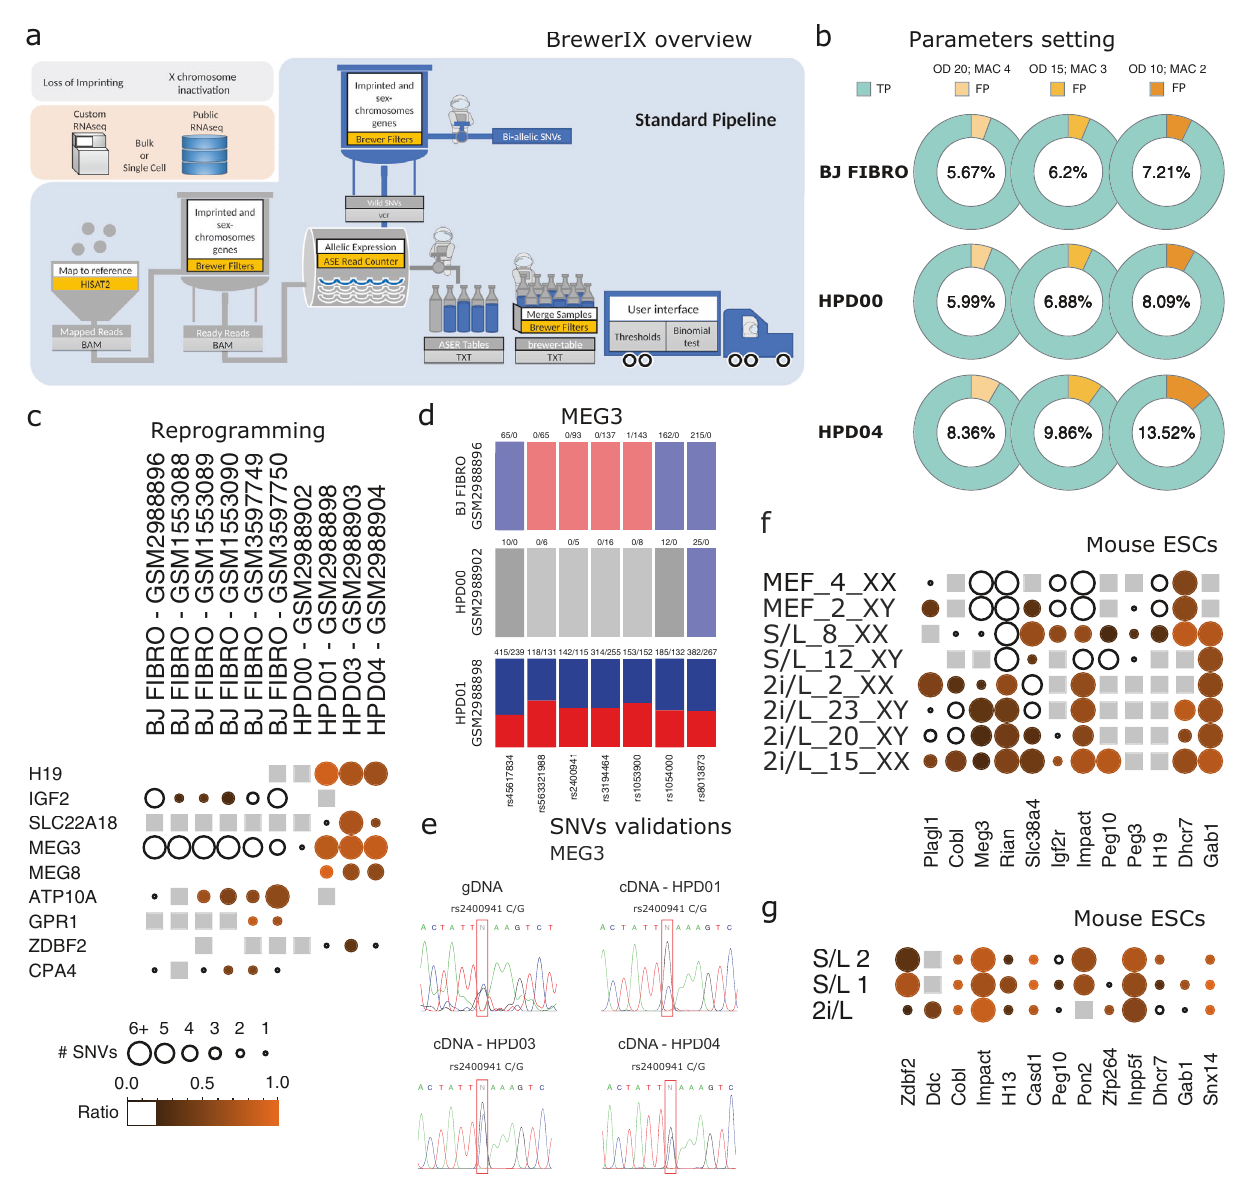
Fig. 1 Analyses of imprinted gene expression in naive pluripotent cells with BrewerIX. a BrewerIX rational and overall implementation scheme for the Standard pipeline. b False discovery rate estimates obtained by comparing WES calls and BrewerIX biallelic calls in one male BJ fi broblast and two iPS cell lines. Three threshold combinations of overall depth (OD) and minimal coverage of the minor allele (MAC) were used; true positives (TP) in cyan; false positives (FP) in shades of orange. c BrewerIX gene summary panel results on bulk RNA-seq data from isogenic human fi broblasts (BJ FIBRO), primed (HPD00) and naive (HPD01/3/4) iPSCs. The larger the dot, the higher the number of SNVs supporting the biallelic call. The brighter the orange, the closer to 1 is the average of the allelic ratios (minor/major) of all the biallelic SNVs. Empty dots indicate detected genes with no evidence of biallelic expression, gray squares indicate genes detected but not reaching the user ’ s thresholds, while the absence of any symbol indicates that the gene was not detected. d BrewerIX SNV summary panel for MEG3 in the case study shown in panel c . A barplot for each sample is reported, with as many bars as the number of SNVs per gene. Solid colors represent actual SNV with both loci expressed, blue and red are the reference and the alternative/minor allele. Transparent colors indicate SNVs detected with no evidence of biallelic expression, while grayscale colors indicate SNVs that do not meet the minimum coverage. e Experimental validation of the indicated MEG3 SNVs by PCR followed by Sanger sequencing. The SNVs of interest are highlighted by a red box. See Supplementary Table 2 for a list of all SNVs validated. Each SNVs was detected in two independent experiments, using either forward or reverse sequencing primers. f BrewerIX gene summary panel results on bulk RNA-seq data generated by Yagi et al. 47 . Murine ESCs were expanded in either 2i/L or S/L conditions, while mouse embryonic fi broblasts (MEF) serve as controls. g BrewerIX gene summary panel results from bulk RNA-seq data of mESCs cultured in 2i/L or S/L (two biological replicates) by Kolodziejczyk and colleagues 48 . See Fig. 2a for matching single-cell RNA-seq